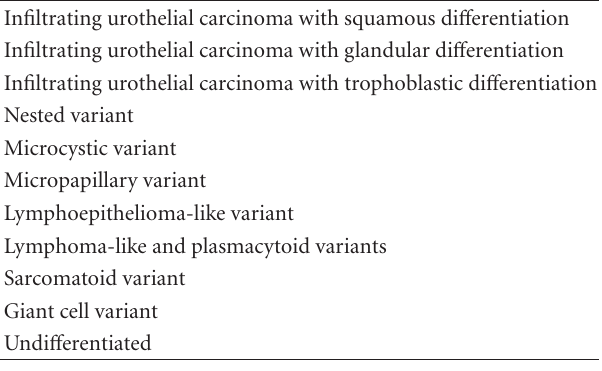
Figure 2: Deep invasive component of MPC displays tight nests or balls of tumor cells in lacuna-like spaces.